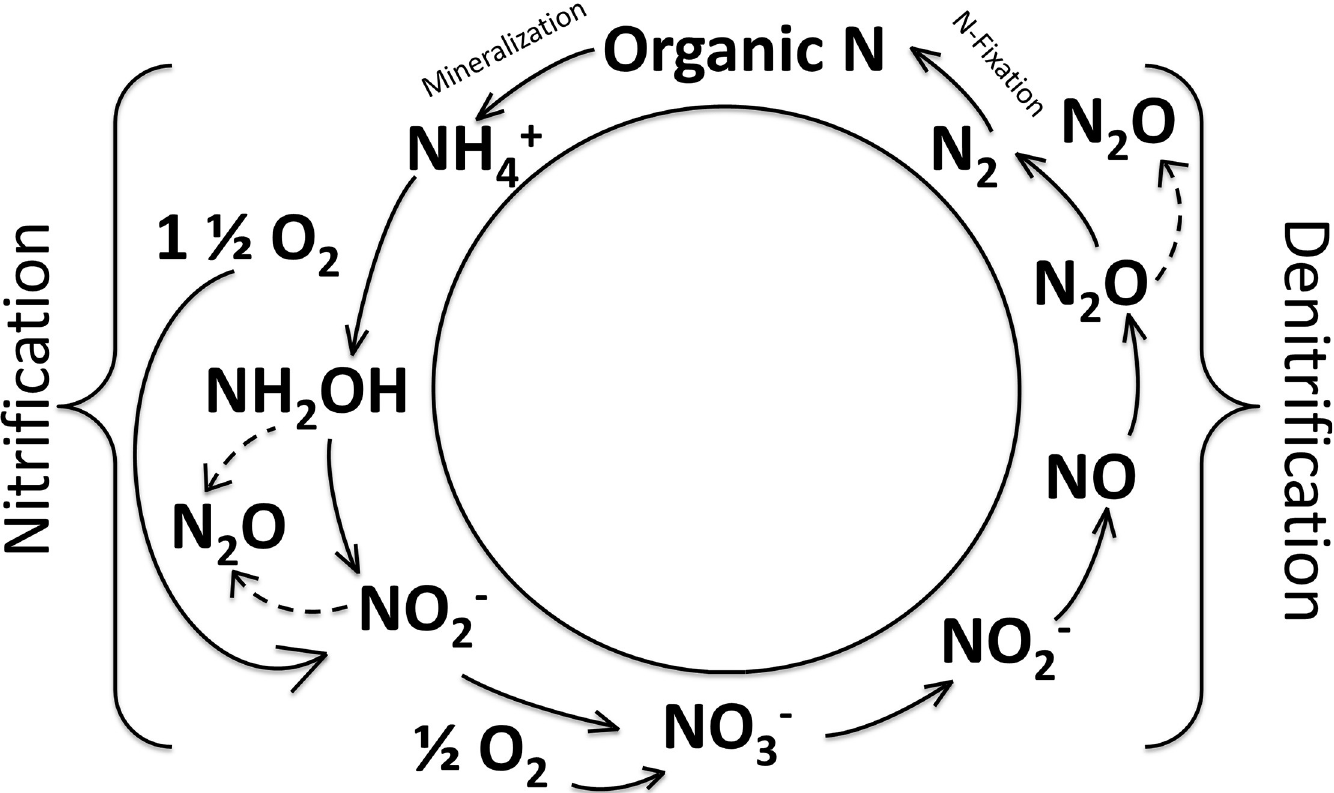
Fig 1. Schematic of the nitrogen cycle, featuring the microbial processes of nitrification (NH 4+ to NO 2– and then to NO 3– ) and denitrification (NO 3– to NO 2– , nitric oxide, N 2 O then to nitrogen gas). For every mole of NH 4+ nitrified to NO 3– , two moles of oxygen are consumed (Stoichiometric relationships collectively found in [5,6,10–13]). Note that the proportion of N 2 O released from nitrification and denitrification is highly variable as indicated by the dashed arrows [14]. Nitrogen assimilation, dissimilatory NO 3– reduction to NH 4+ (DNRA) and anaerobic NH 4+ oxidation (anammox) are excluded from the figure but may be important components of the nitrogen cycle